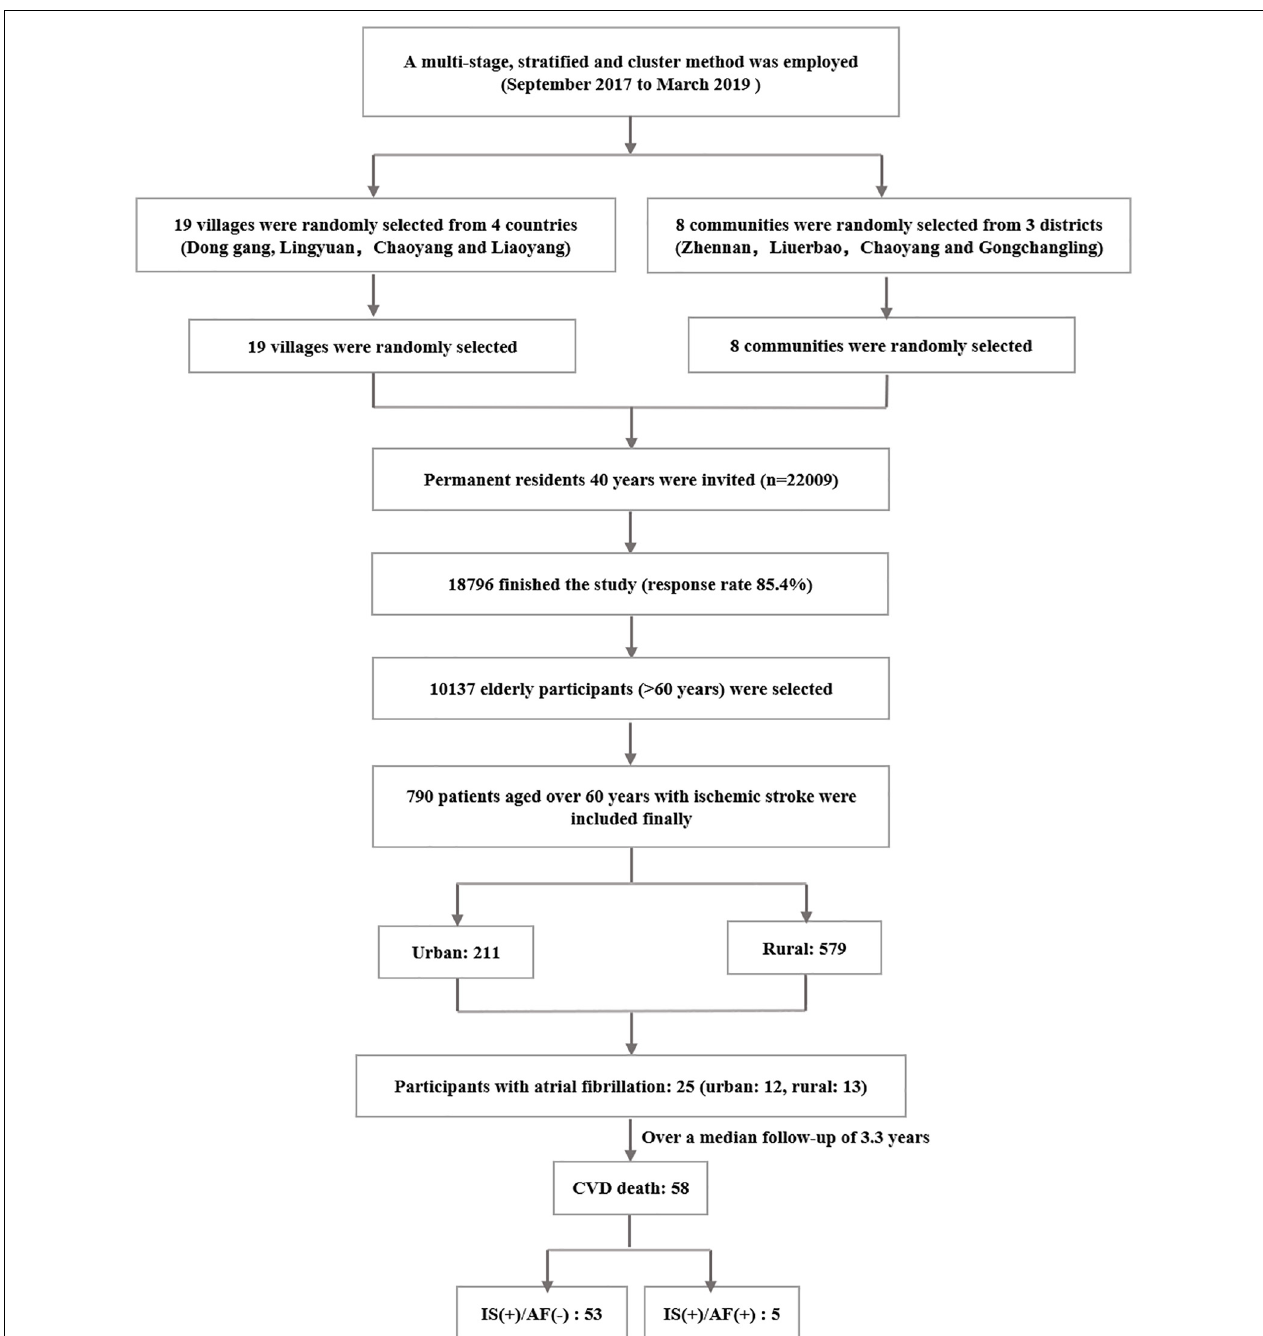
FIGURE 1 | Flow chart of the patient selection process.